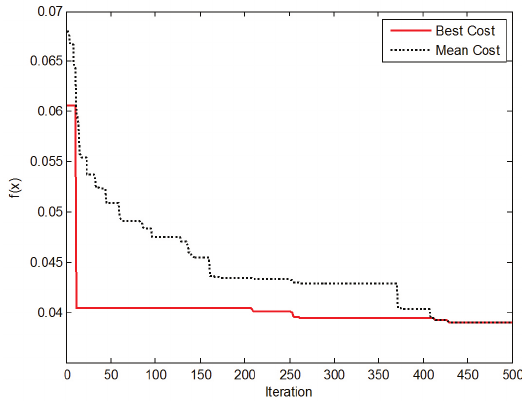
Figure 10. Convergence of the ICA to the optimal solution.